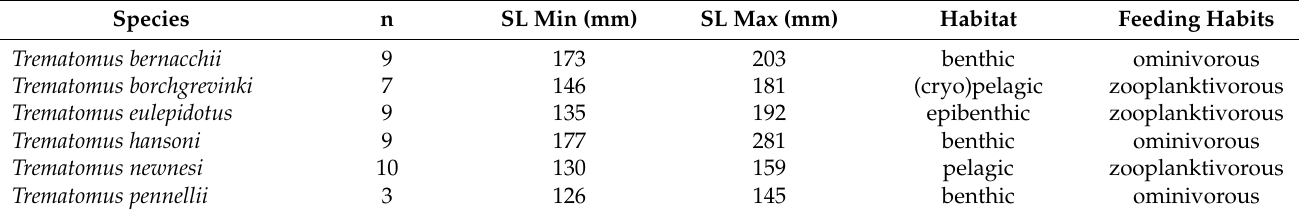
Table 1. Trematomus species investigated (standard length (SL) range, habitat preference and feeding